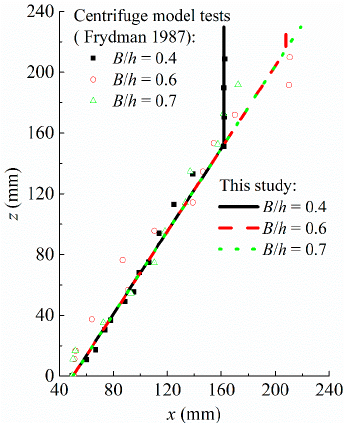
Figure 5. Comparison of slip surface with centrifuge model tests.